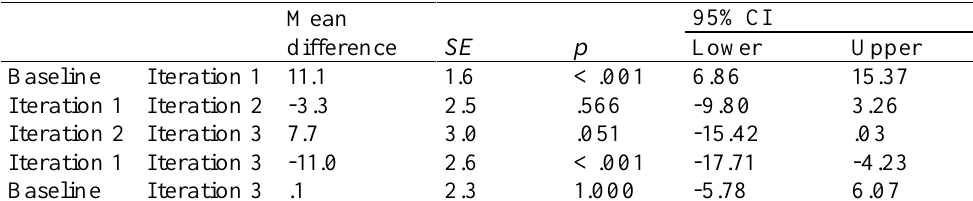
Tukey Post-Hoc Analysis of SOC in Each Iteration